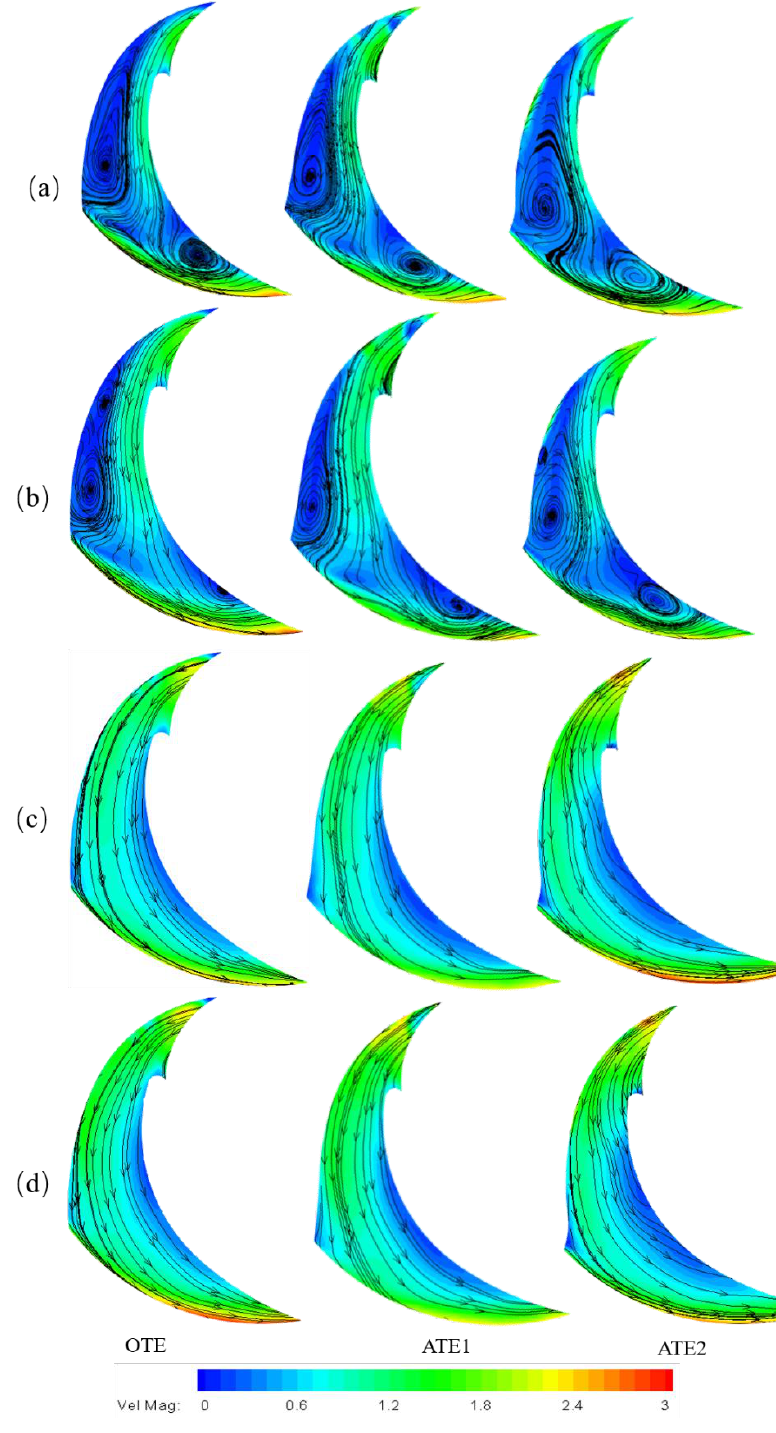
Figure 5. Relative velocity distributions at different flow rates: ( a ) 0.2 Q BEP ; ( b ) 0.4 Q BEP ; ( c ) 1.0 Q BEP ; and ( d ) 1.2 Q BEP .